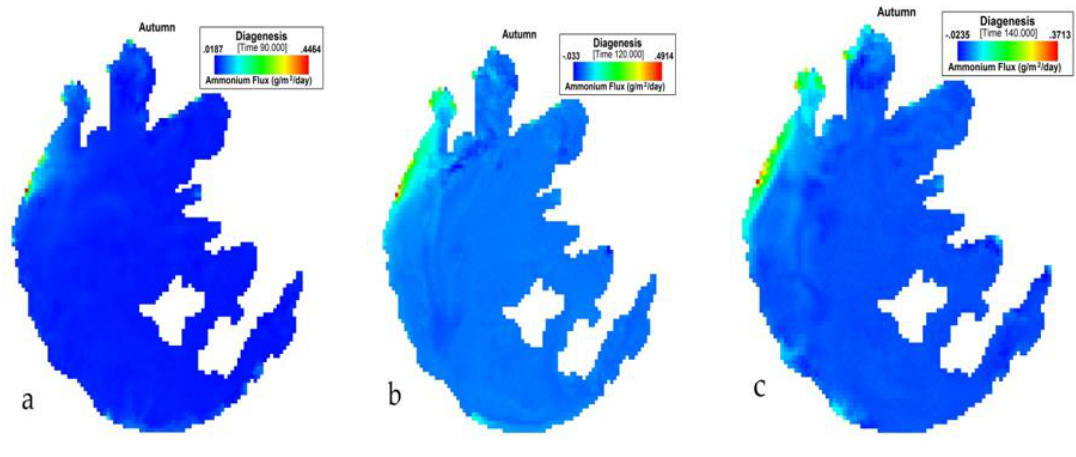
Figure 7. ( a ) 90th, ( b ) 120th, ( c ) 140th day simulation of NH 4 flux variation during autumn at Figure 7. (a) 90 th , (b) 120 th , (c) 140 th day simulation of NH 4 flux variation during autumn at Taihu.